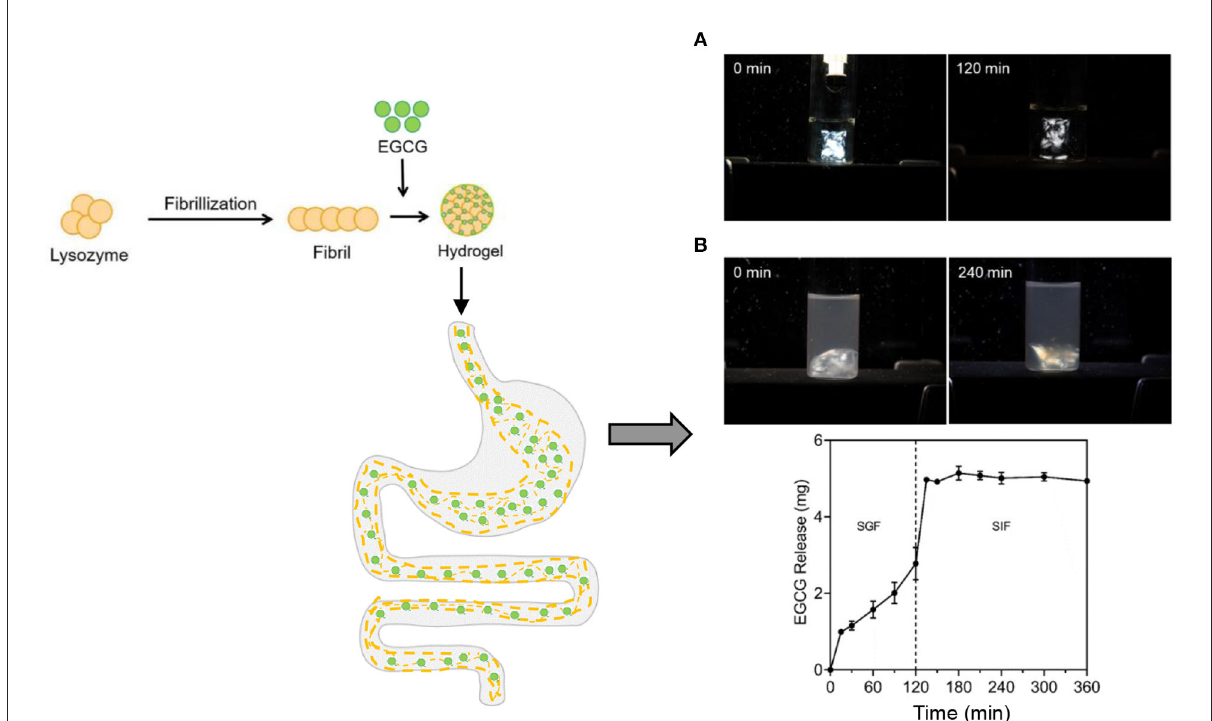
FIGURE6 The formation of cold-set hydrogels formed through the self-assembly of polyphenol epigallocatechin gallate (EGCG) and the protein fibrils originating from egg white lysozyme as well as the digestion of the hydrogels and the controlled release of the encapsulated EGCG in the simulated GI tract: (A) simulated gastric fluid (SGF) and (B) simulated intestinal fluid (SIF). The hydrogels showed birefringence under the polarized